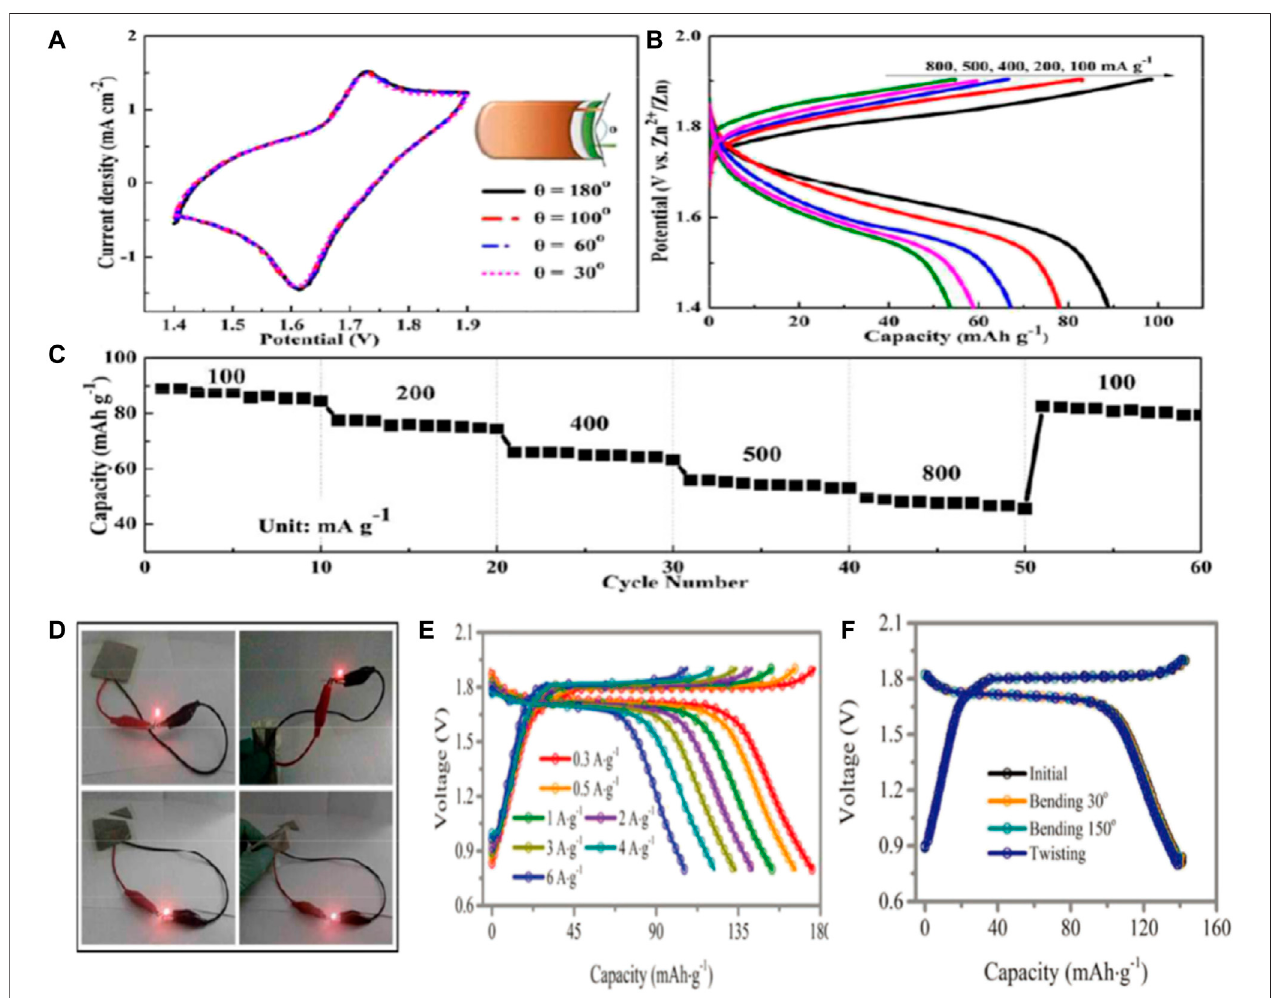
FIGURE 5 | Performance of fl exible solid-state rechargeable zinc ion battery with ZnHCF@MnO 2 nickel foil as cathode (A) CV curves under different bending conditions at 1 mV/s; (B) Charge-discharge curves under different current densities; (C) Multiplier performance of fl exible cells; (D) Photographs of the fl exible zinc batteries powering the LED bulbs in their originaland cut state respectively Copyright 2017 J. Mater. Chem. A. Electrochemical performance ofZn/CoFe(CN) 6 cells with 4 m Zn(OTf) 2 electrolyte (E) constant current charge-discharge curves under different current densities; (F) Solid-state cable battery: constant current charge- discharge curve and torsional deformation of battery at different bending angles of 60 ° and 150 ° when the fi xed device length is 10 cm and bending radius is 1 cm.